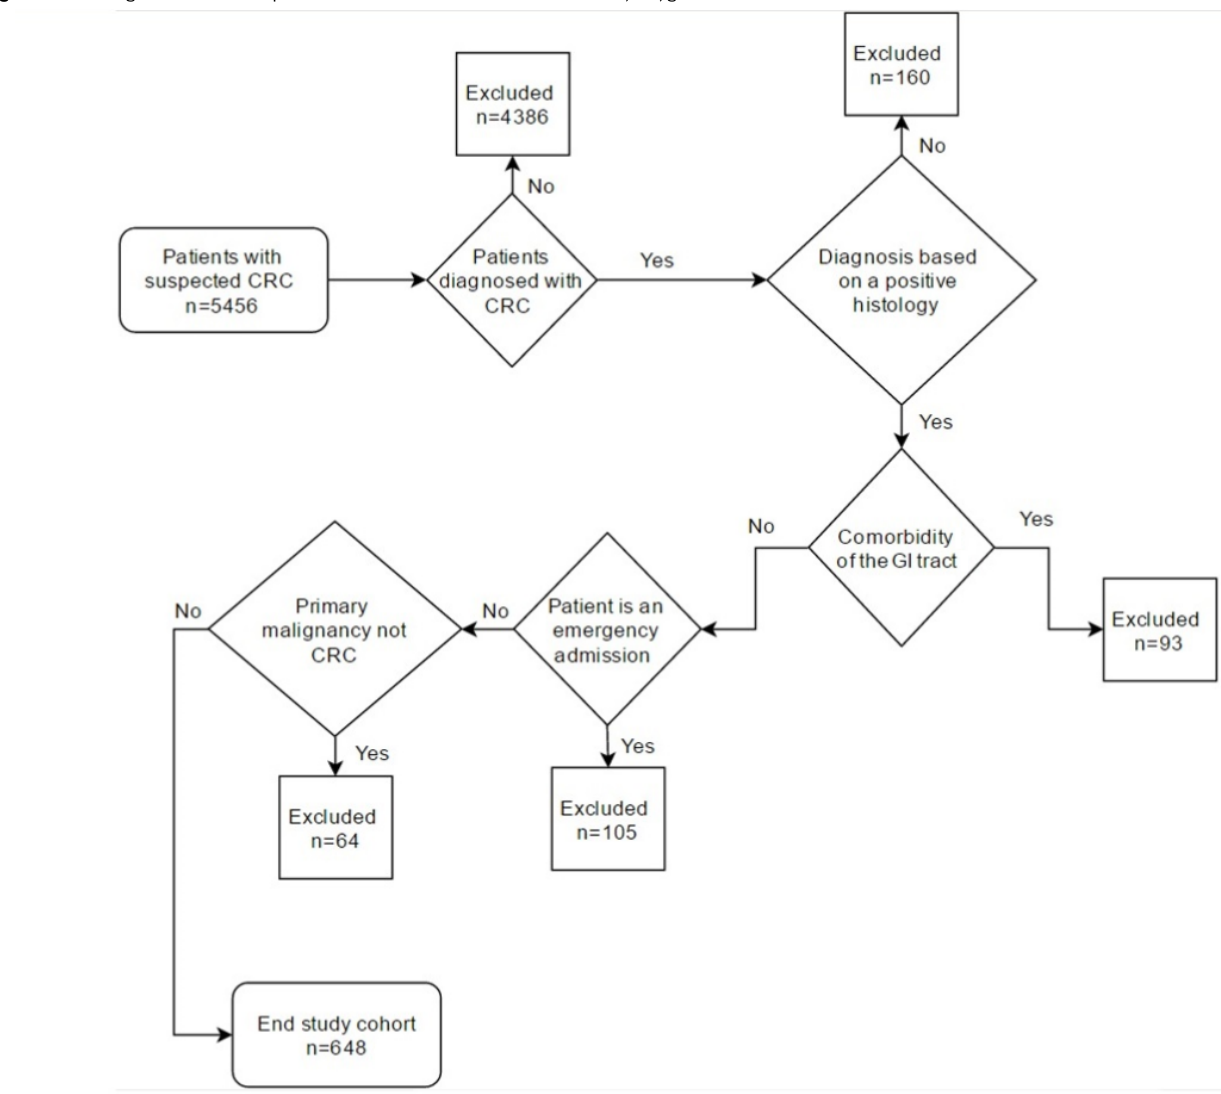
Figure 1. The algorithm used for patient inclusion. CRC: colorectal cancer; GI,